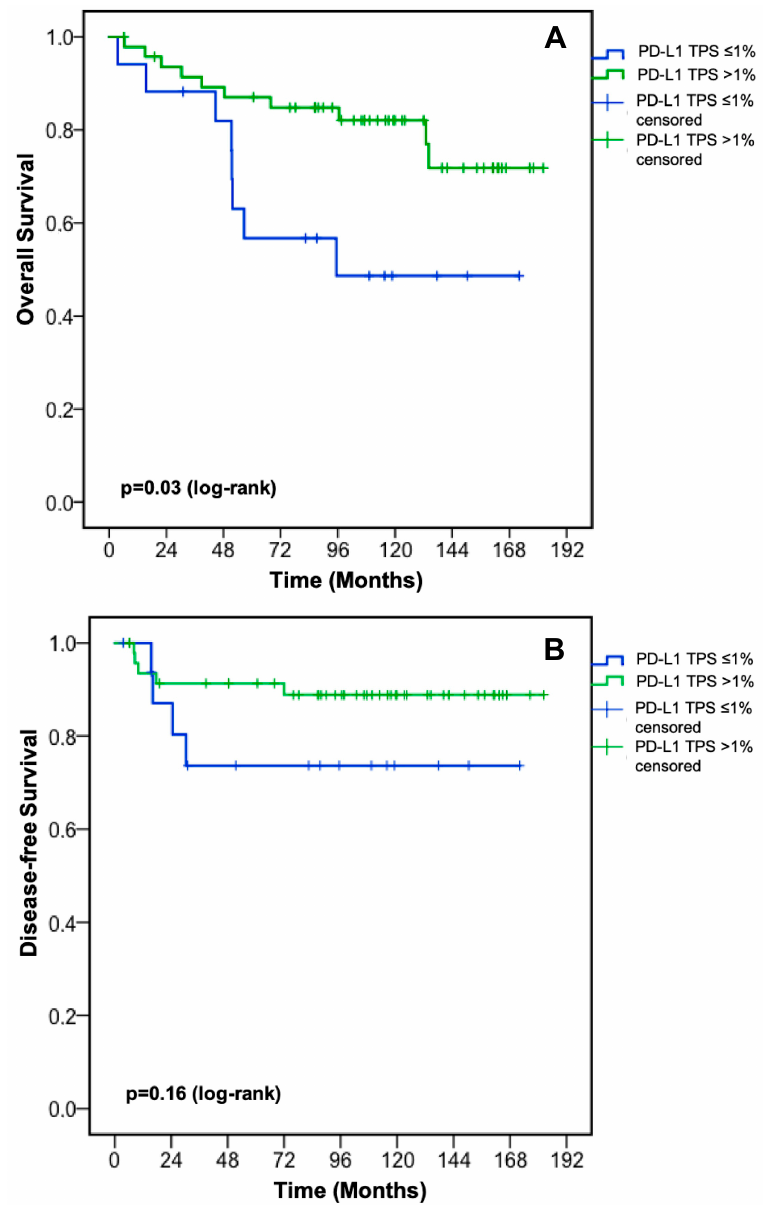
Figure 3. Overall survival ( A ) and disease-free survival ( B ) according to PD-L1 TPS prior to neoadjuvant CRT. CRT: chemoradiotherapy; PD-L1: programmed death-ligand 1; TPS: tumor proportion score. The tick marks on the curves represent censored patients.